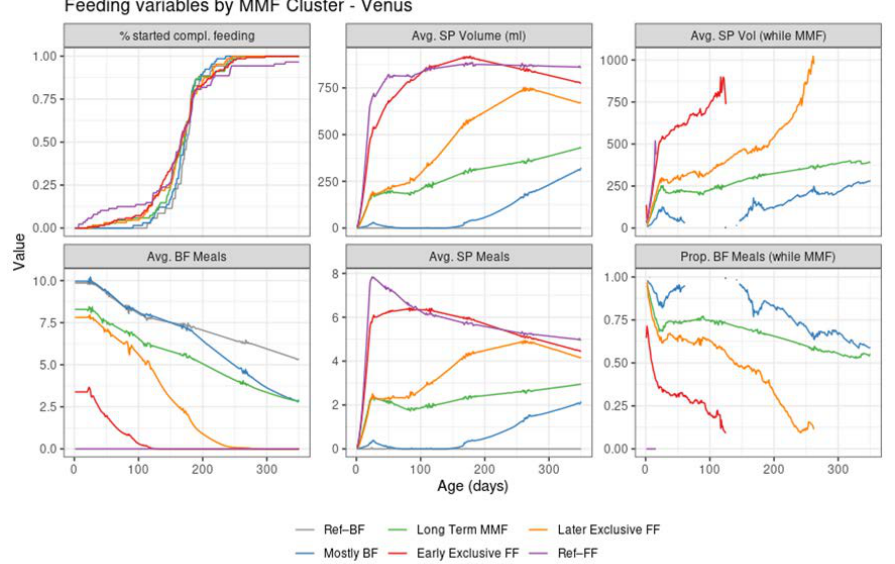
Figure 5. Summary of feeding variables in Venus per cluster from birth (leftmost) to 350 days of age (rightmost). First row: % started compl. Feeding—percentage of subjects that introduced complementary feeding; Avg. SP Volume (mL)—average of estimated daily study product volume intake across all subjects in the cluster; Avg. SP Vol (while MMF)—average of estimated study product volume intake in ml per day across the subjects in the cluster who are mixed feeding at that time point. Second row: Avg. BF Meals—average of the estimated daily number of daily BF meals; Avg. SP Meals—average of the estimated daily number of daily study product meals; Prop. BF Meals (while MMF)—proportion of BF meals from the total of BF meals and study product meals.